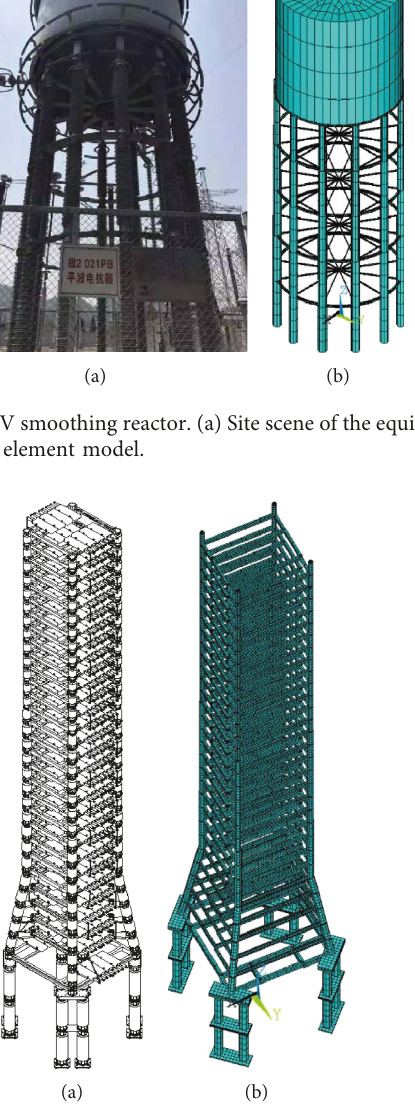
Figure 8: UHV filter tower. (a) Structural assembly drawing and (b) finite element model.